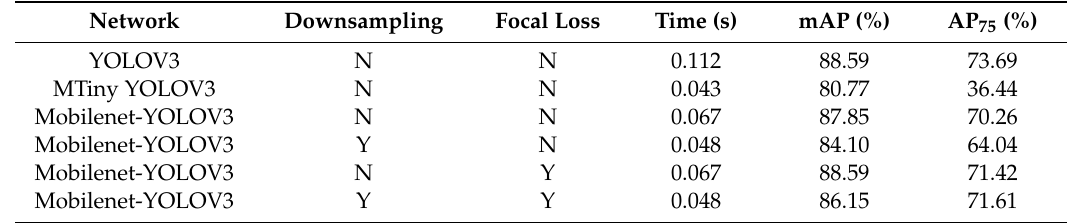
Table 7. Results of the framework with di ff erent